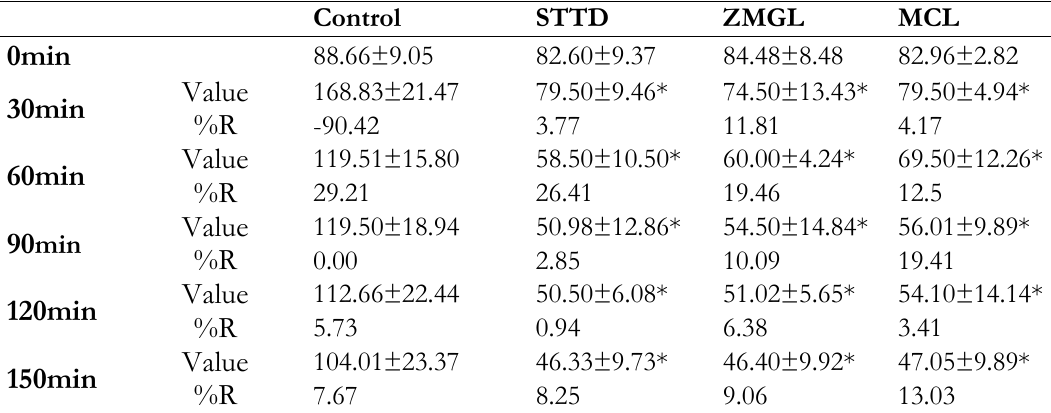
Table VI. Comparative hypoglycemic effect of leaf extracts of two lines of G. sylvetre and